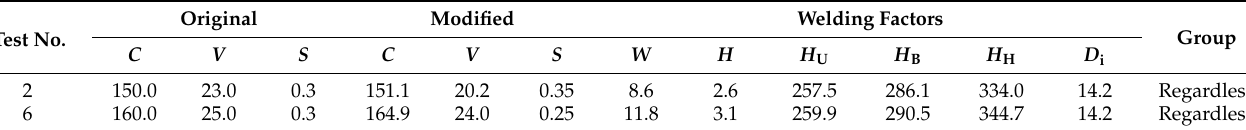
Table 13. Results of welding parameters modified by optimization process.